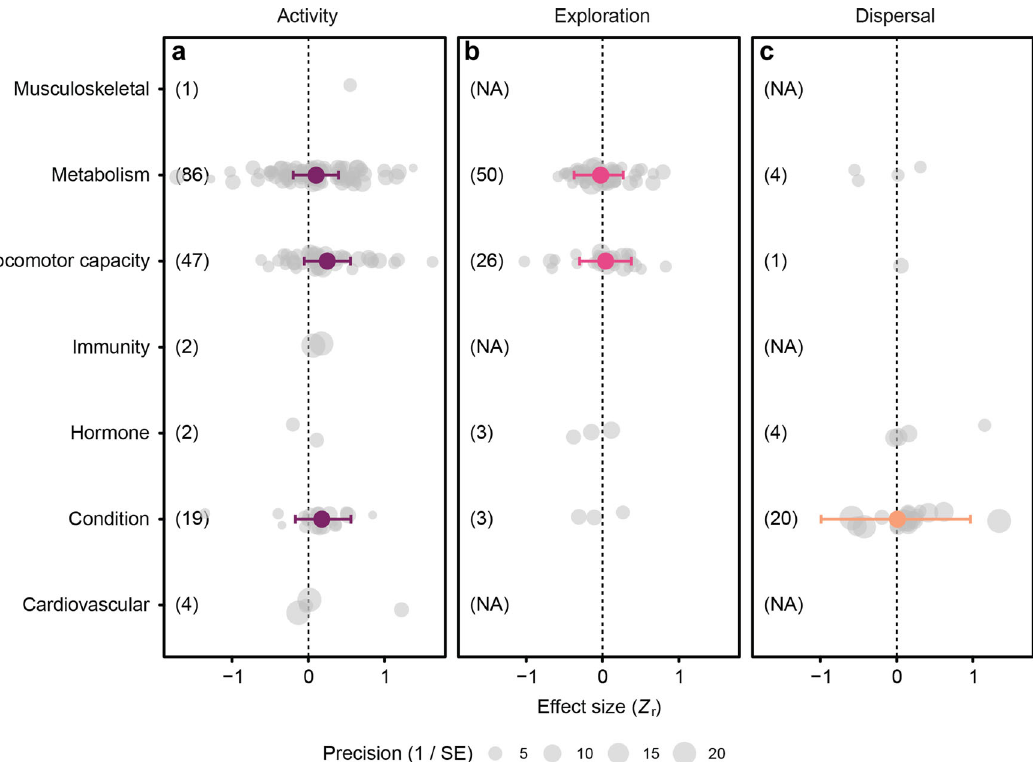
Fig. 2 Effects of physiological traits on activity, exploration and dispersal. a Activity in familiar environments. b Exploration of novel environments. c Dispersal. The only effect with reasonable con fi dence was the effect of locomotor capacity on activity. Only traits with more than fi ve effect sizes were analysed. Numbers in brackets indicate a number of effect sizes (NA = not available). Grey points represent individual effect sizes, and the size of each symbol indicates study precision (inverse of standard error). Effect sizes ( Z r ) are estimates ±95% credible